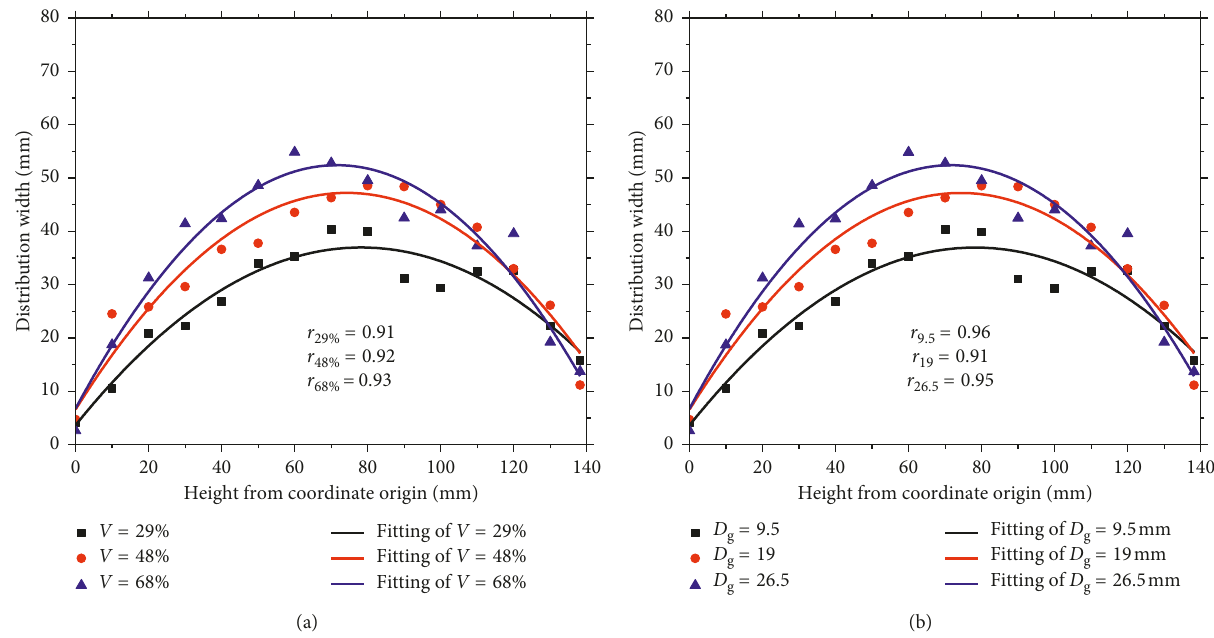
Figure 8: (a) The volume rate of the coarse aggregate and the distribution width of the fracture path at a different height; (b) the maximum size of the coarse aggregate and the distribution width of the fracture path at a different height.